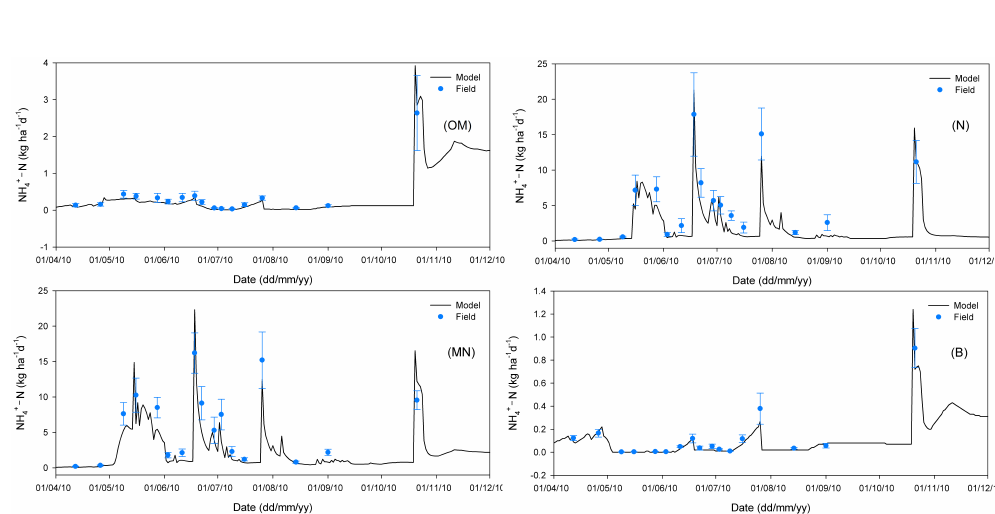
) for the top 10cm of the soil profile in summer maize 4